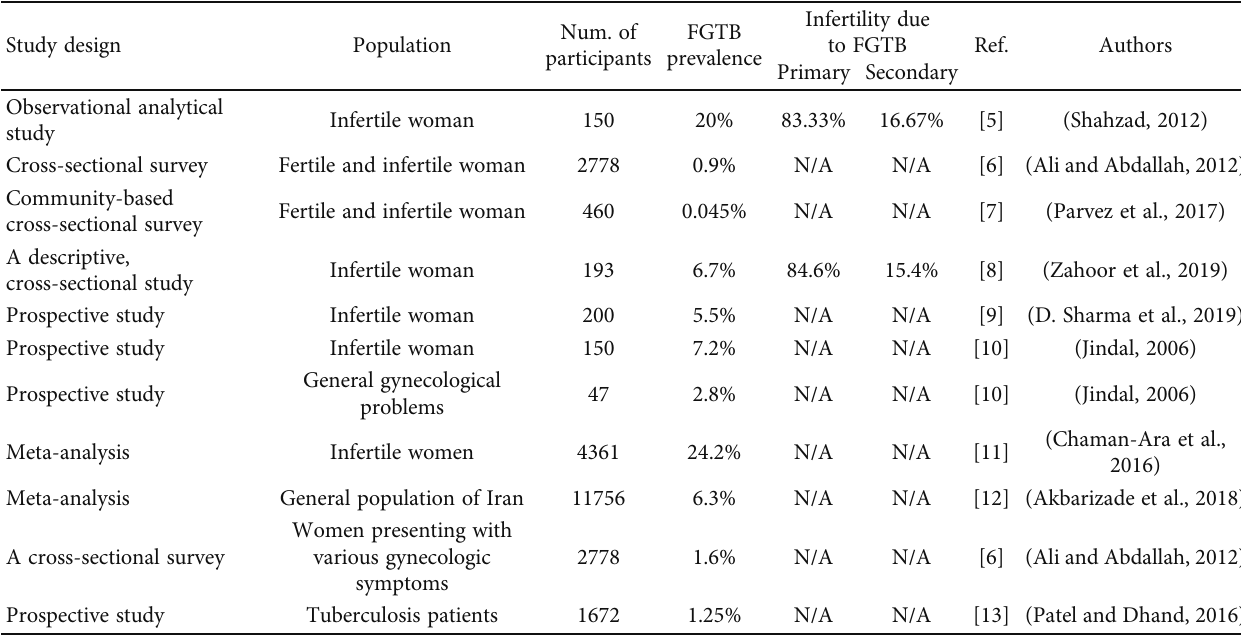
Table 1: Characteristics of quoted